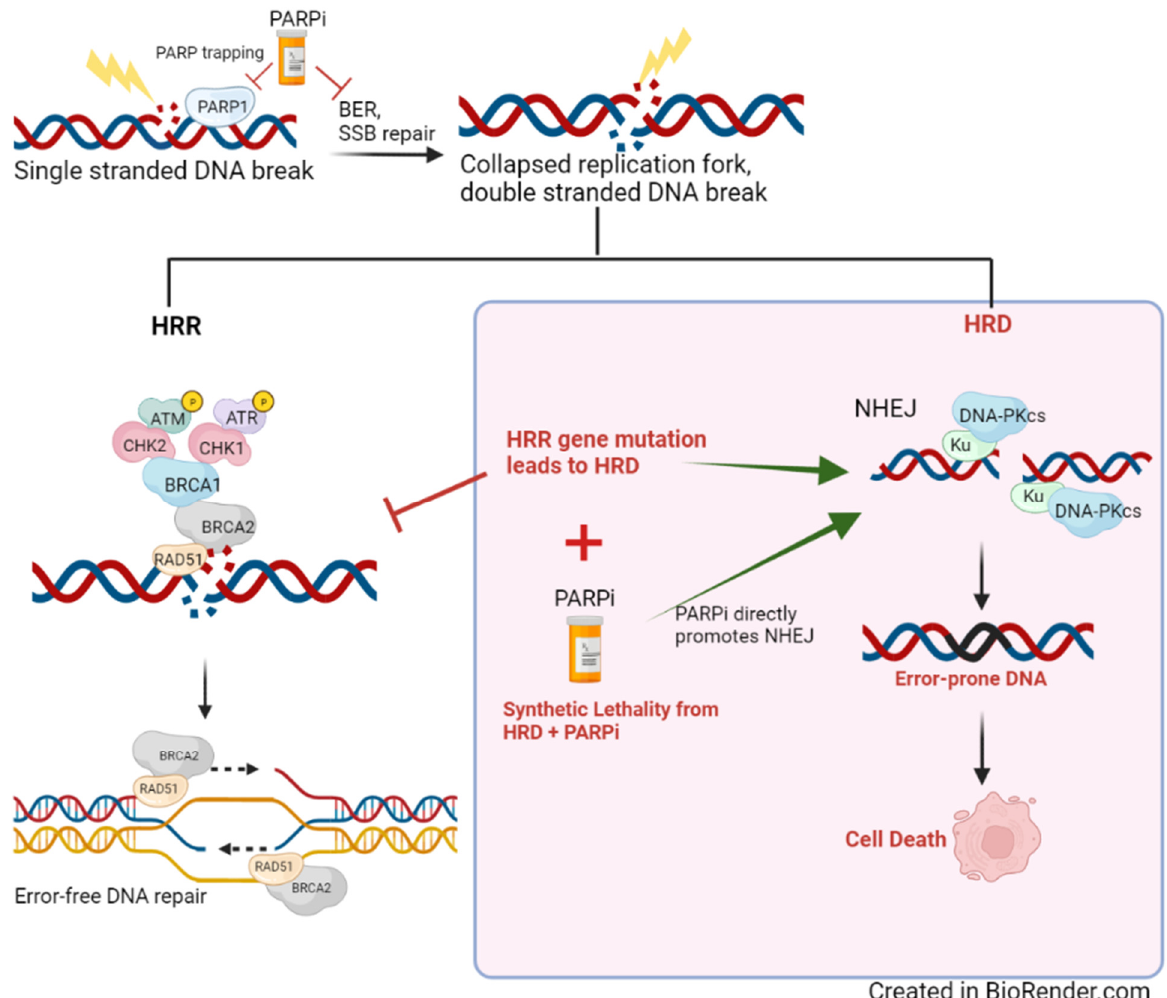
Figure 2. Graphical representation of HRD (homologous repair deficiency), which lends to synthetic lethality with PARPi use. PARPi directly inhibits BER in ssDNA repair, which leads to double- stranded DNA during replication. In the setting of HRD, DNA repair is relegated to error-prone pathways (e.g., NHEJ), which leads to cell death.